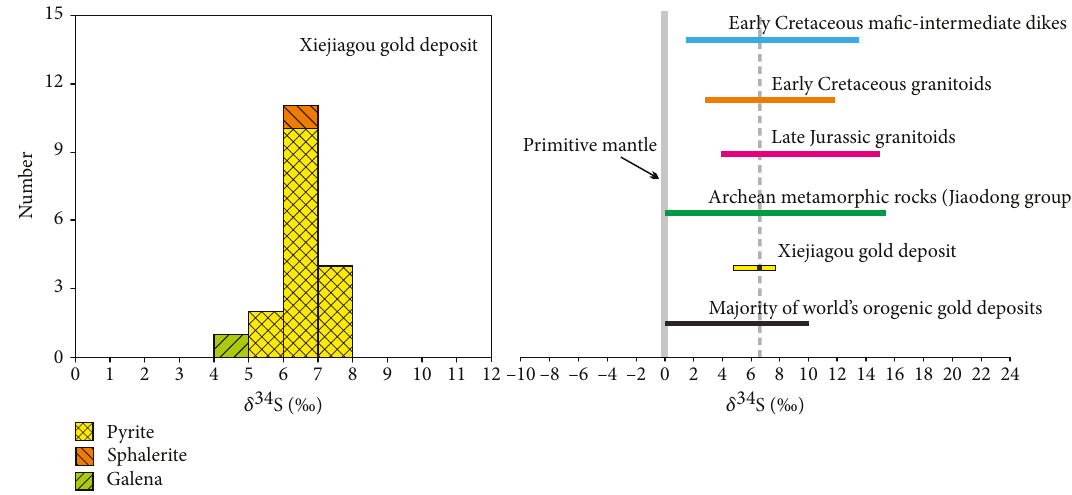
Figure 13: δ 34 S values of sul fi des from the Xiejiagou deposit and related lithologies. δ 34 S values of di ff erent lithologies at the Jiaodong deposit are quoted from Yang et al. [19] and the references therein. The fi eld for orogenic gold deposits revised after Goldfarb et al. [82].